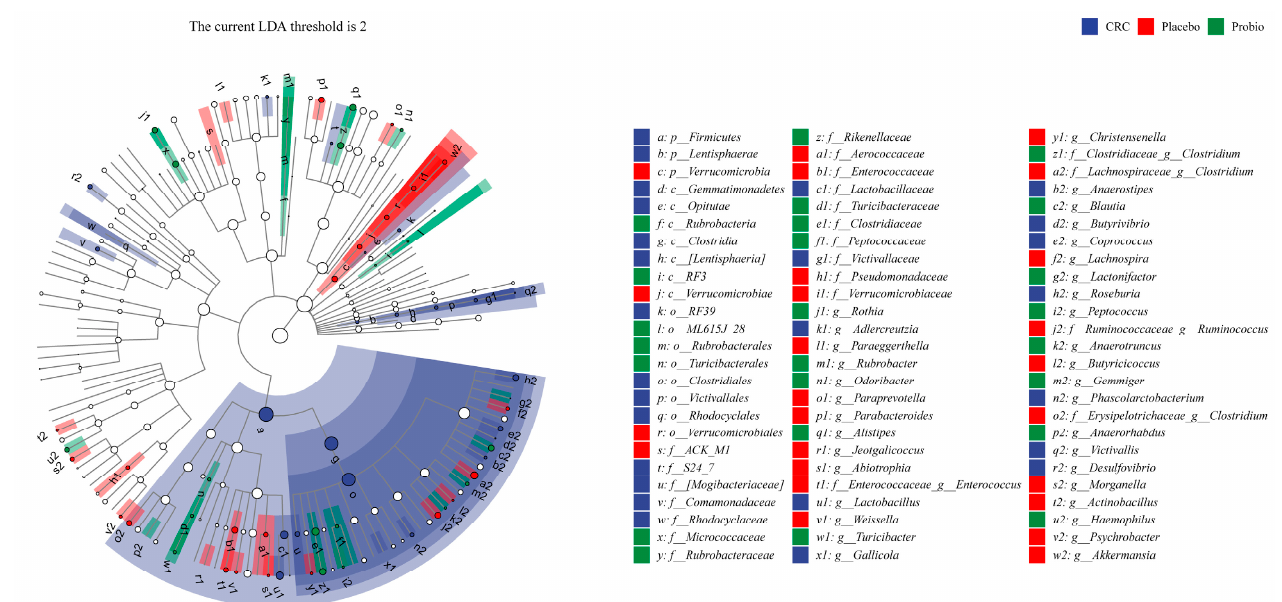
Figure 4. LEfSe cladogram showing differently abundant gut microbiota taxa among CRC patients at different levels. The current LDA threshold score is over 2; p , phylum; c , class; o , order; f , family; g , genus. The blue, red, and green color refers to different bacterial taxa in CRC group, Placebo, and Probio group, respectively.